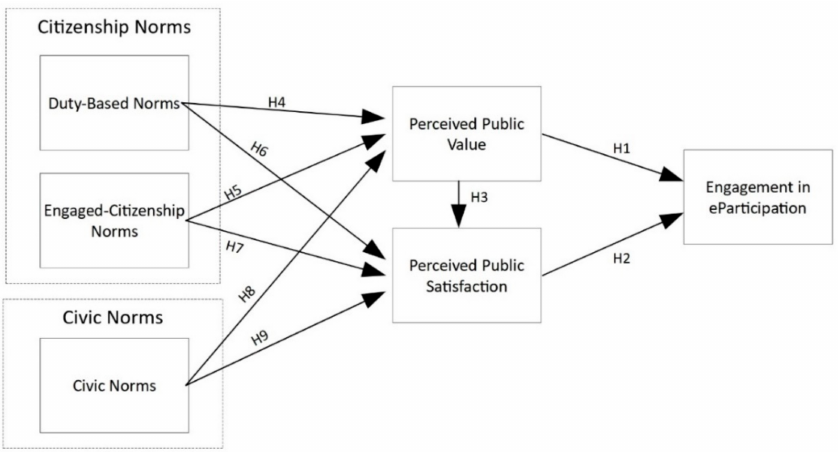
Figure 1. Underlying research model.